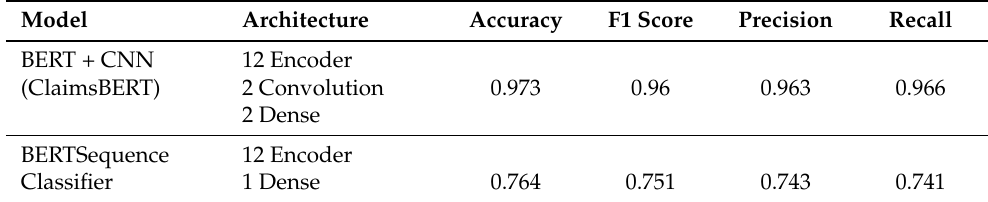
Table 2. Comparing classification performance of ClaimsBERT with BertForSequenceClassification.